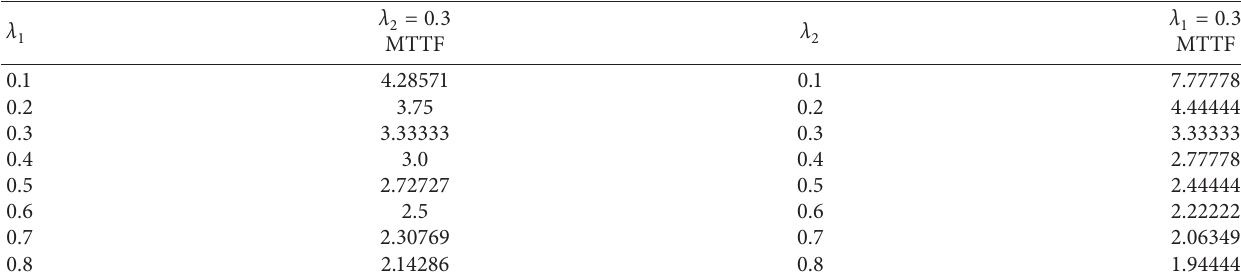
and λ when ( α � 0 . 6). 1 1